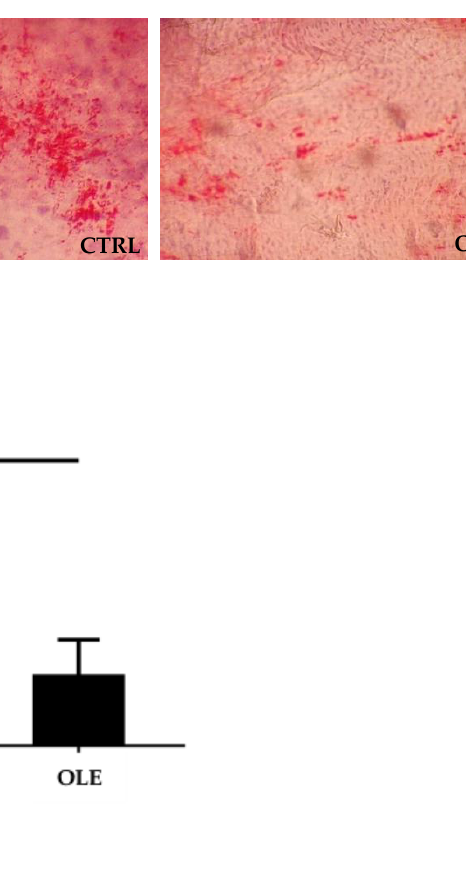
Figure 2. Oleactiv ® modulation of hamsters’ lipid profile: analysis of total cholesterol (TC) ( A ) HDL- C; ( B ) triglycerides (TG); ( C ) and non-HDL-C; ( D ) after 12 weeks of supplementation, in hamsters fed with a standard diet (STD group), a high-fat diet (CTRL group), or a high-fat diet and Oleactiv ® . Statistical analysis were performed using ANOVA one way, with Dunnett’s multiple comparison test.